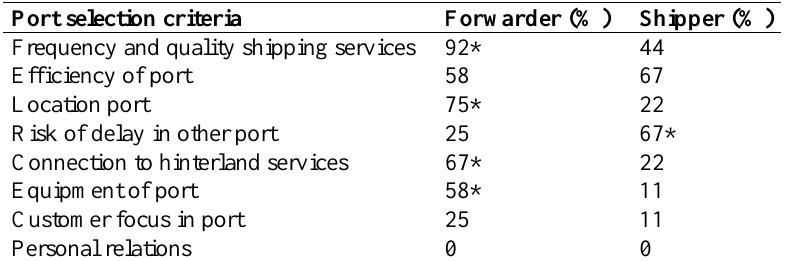
Table 3. Reasons for selecting a more expensive port (% of all forwarders/shippers that mentions reason)